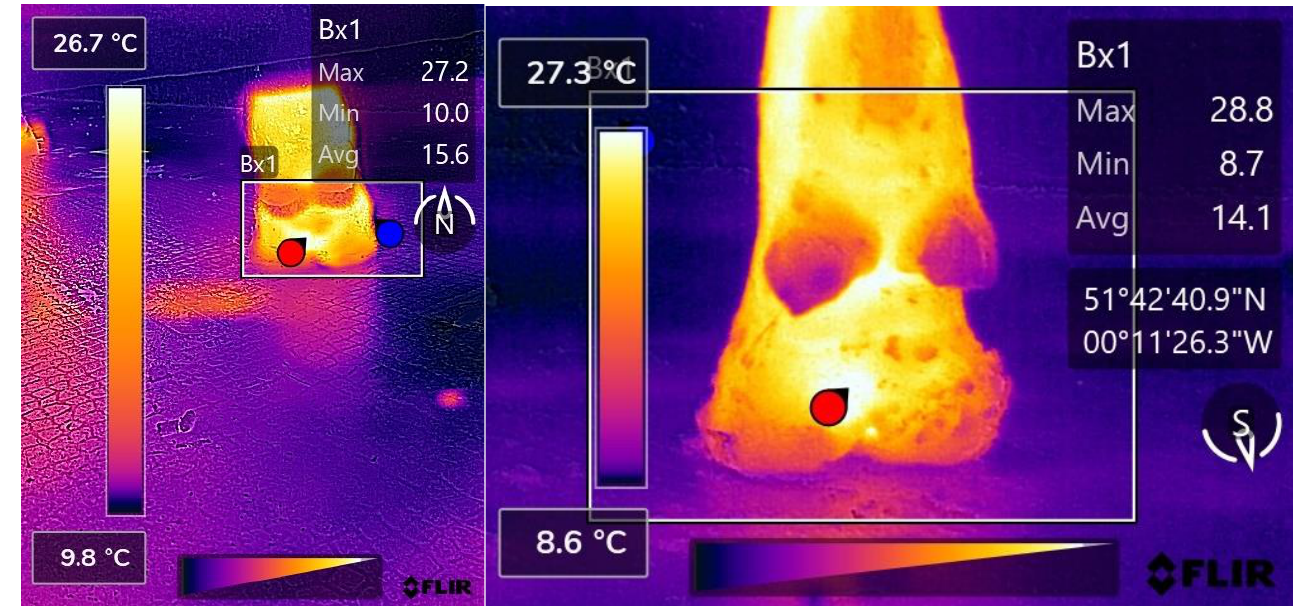
Figure 3. ( Left ) A thermogram captured by the CAT s62 Pro Smartphone and processed with FLIR Thermal Studios showing the point of maximum temperature within Bx1, labelled by the red marker, recorded as being caudal to the heel-bulbs on the medial side of the medial claw. The maximum temperature value transferred for statistical analysis from this thermogram was 27.2 °C. ( Right ) A thermogram captured by the FLIR T620bx and processed with FLIR Thermal Studios showing the point of maximum temperature within Bx1, labelled by the red marker, recorded as being caudal to the heel-bulbs on the medial side of the medial claw. The maximum temperature value transferred for statistical analysis from this thermogram was 28.8 °C.